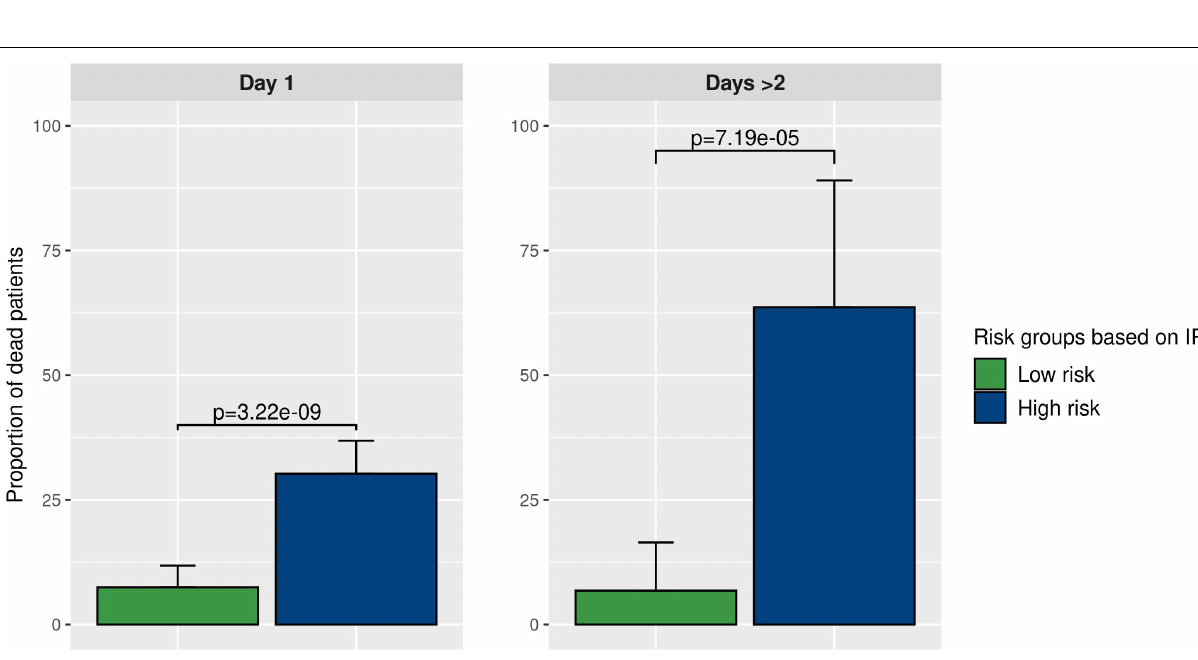
Frontiers in Medicine |